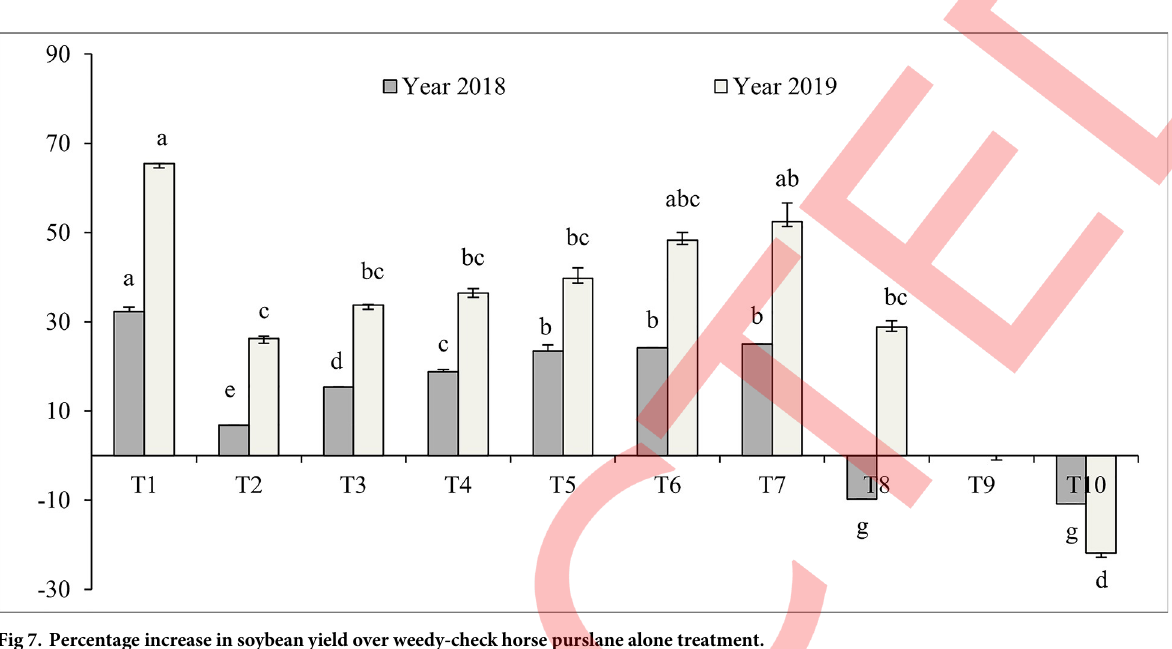
Fig 7. Percentage increase in soybean yield over weedy-check horse purslane alone treatment.